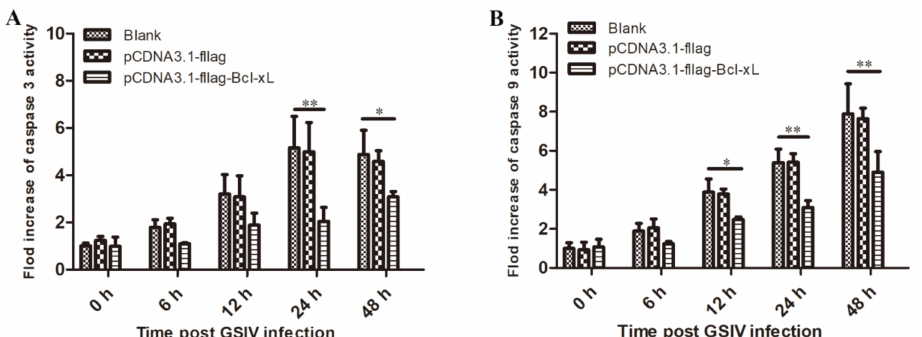
Figure 4. Caspase activity of normal GSM cells, pCDNA3.1-fla-transfected GSM cells, and pCDNA3.1- flag-AdBcl-xL-transfected GSM cells induced by GSIV infection at the indicated time points. Caspase- 3 ( A ) and caspase-9 ( B ) activities were determined using fluorescein-active caspase-staining kits in a fluorescence plate reader. Error bars represent the mean ± SD; * p < 0.05, ** p < 0.01.